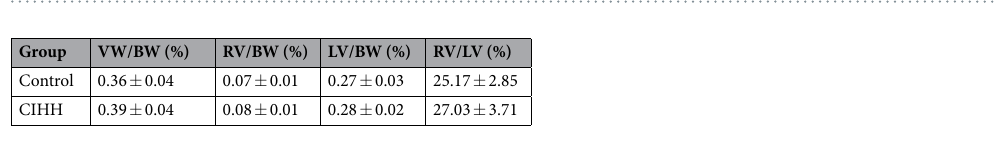
Table 2. Effect of CIHH on heart weight in rats. BW: body weight; VW: ventricles weight; RV: right ventricle weight; LV: left ventricle weight. All Data were expressed as mean ± SD, n = 6 for each group.